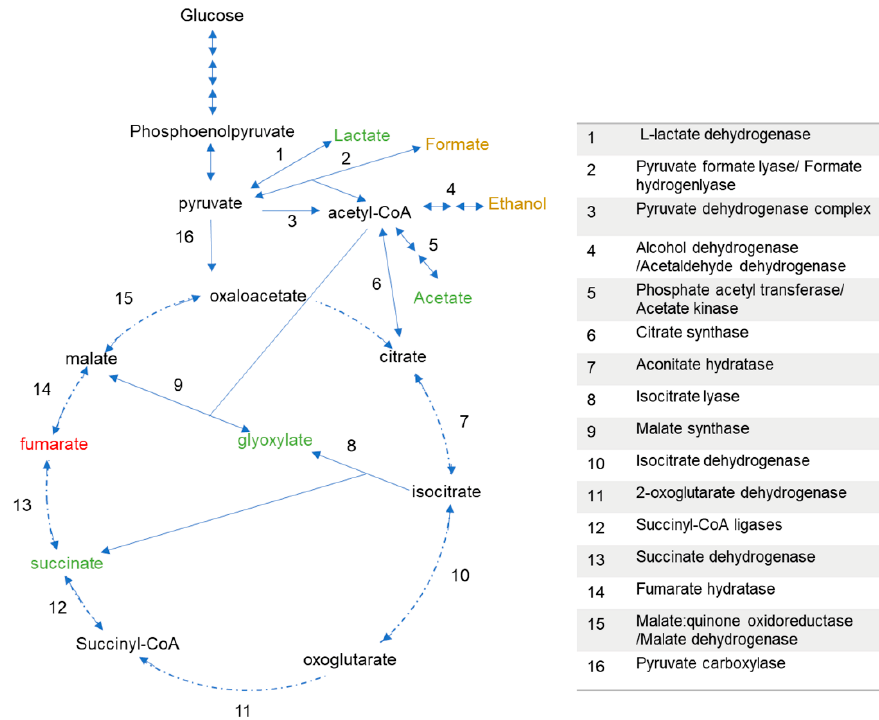
Figure 5. Concentrations of ( a ) acetate and ( b ) lactate during growth of P. thermoglucosidasius DSM 6285 under different initial carbon monoxide atmospheres (0, 25, 50, 75 and 100% CO). Maximum concentrations of both compounds occurred at ~10 h when ~50% of the initial O 2 was depleted. Reported values represent means of triplicate experiments ± standard deviation.